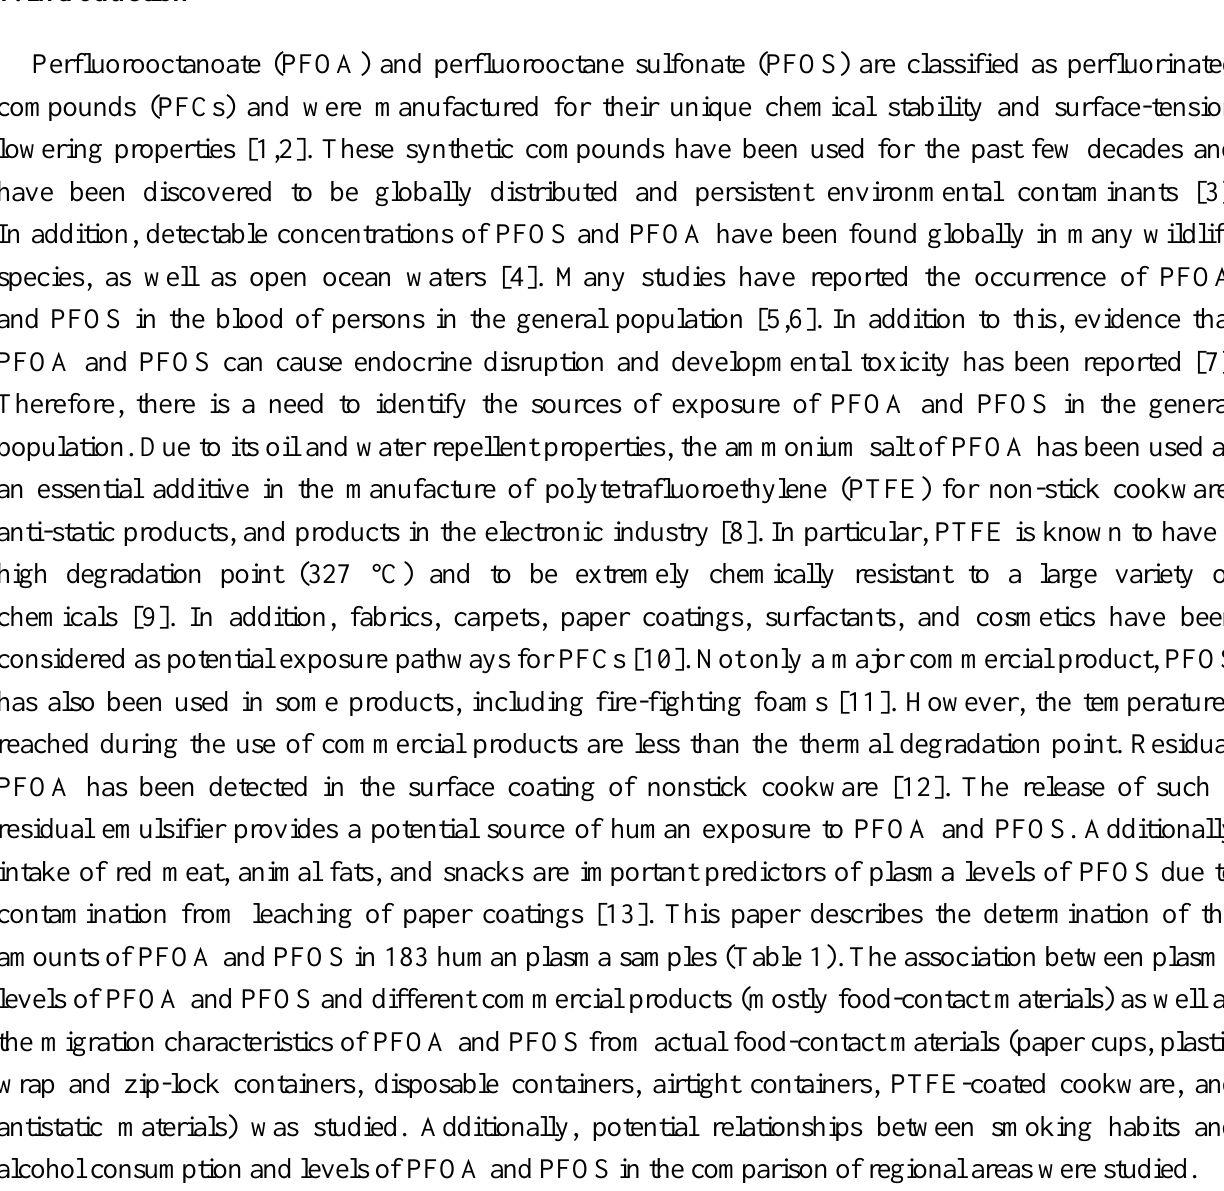
Table 1. The amounts of PFOA and PFOS in 183 human plasma (ng/mL).